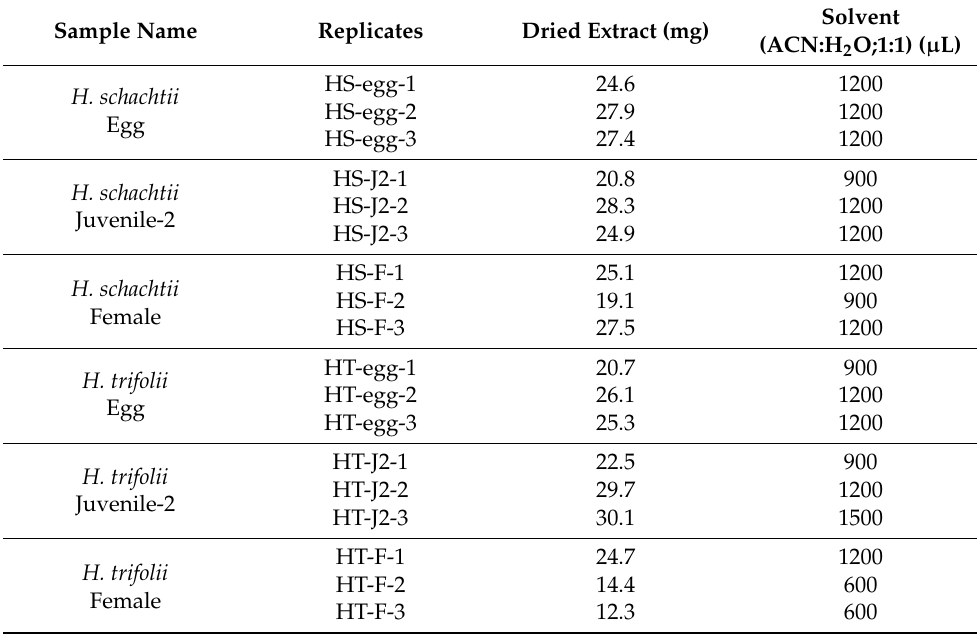
Table 3. Sample of H. schachtii and H. trifolii used for metabolite